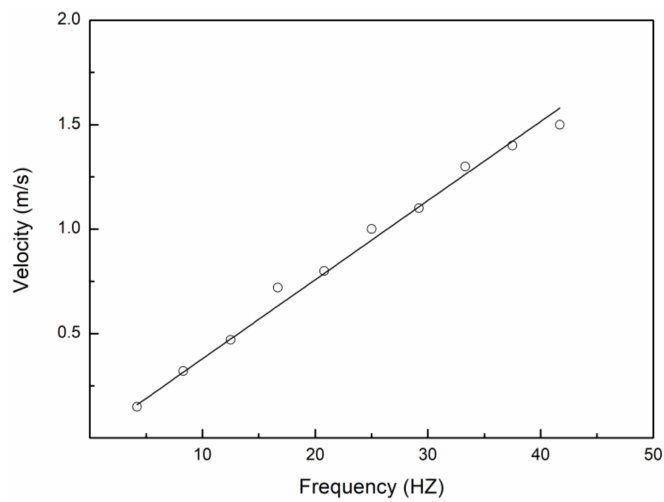
Figure A1. Velocity-modulator frequency relationship. The flow velocity in the test area had a linear relationship with the frequency displayed by the motor, fitting the equation y = 0.03788 x (where x is the modulator frequency and y is the water